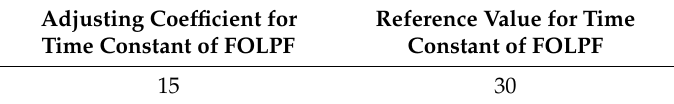
Table 6. Parameters of multi-timescale coordinated control (Quasi-real-time and real-time